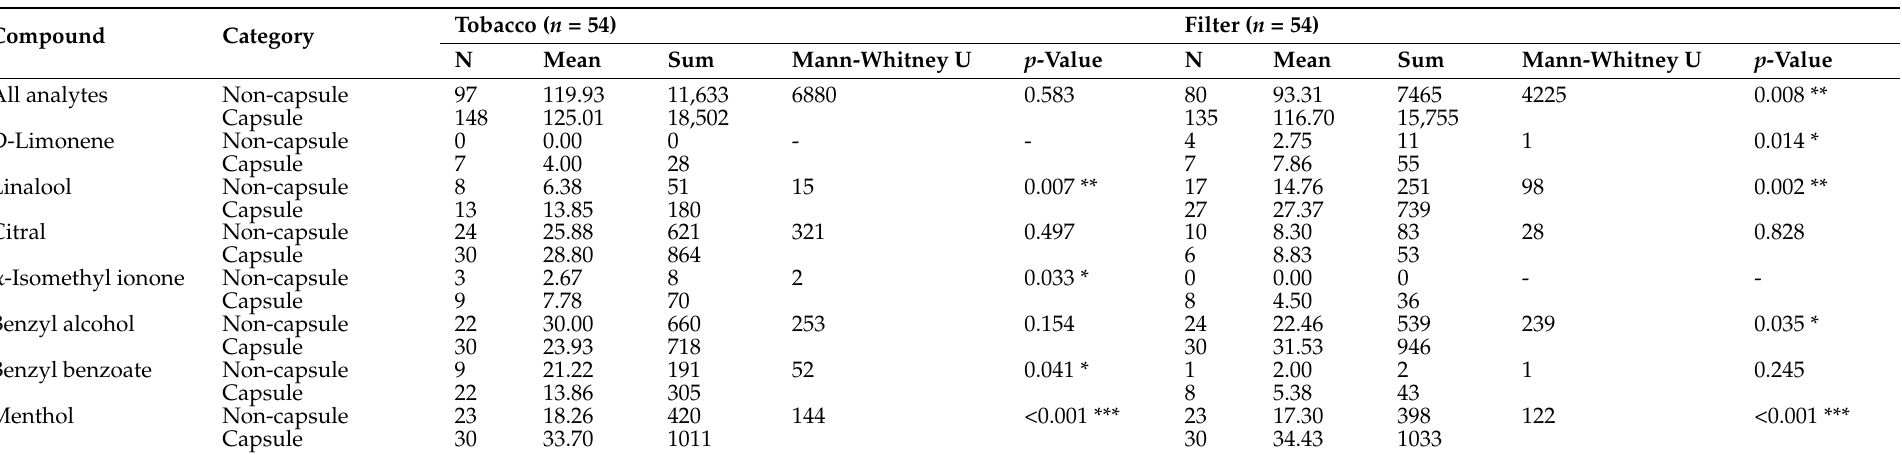
Table 4. Comparison of flavoring agents detected in capsule cigarettes and non-capsule